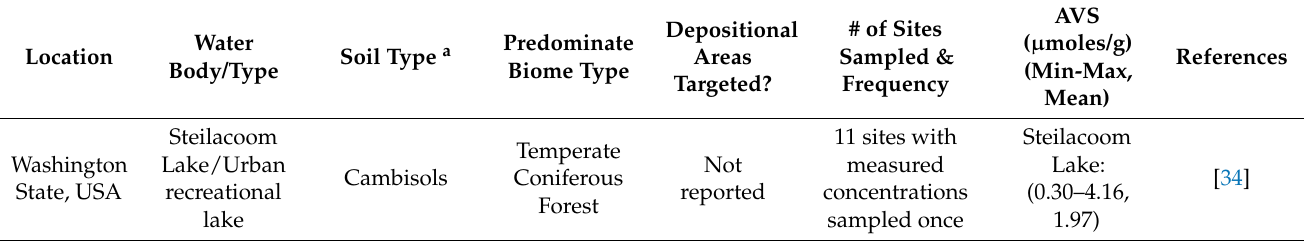
Table 3. Summary of historical acid-volatile sulfides (AVS) sediment data from ponds, lakes and